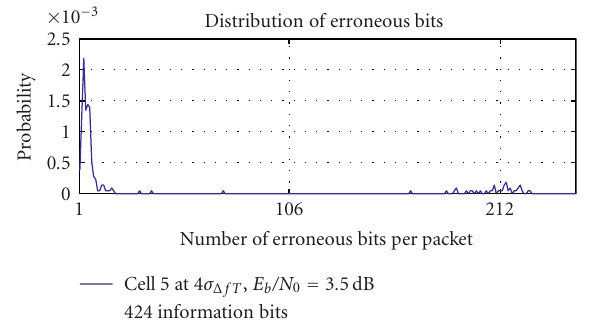
Figure 13: Distribution of erroneous bits: σ Δ fT = 5 · 10 − 4 , itera- tion